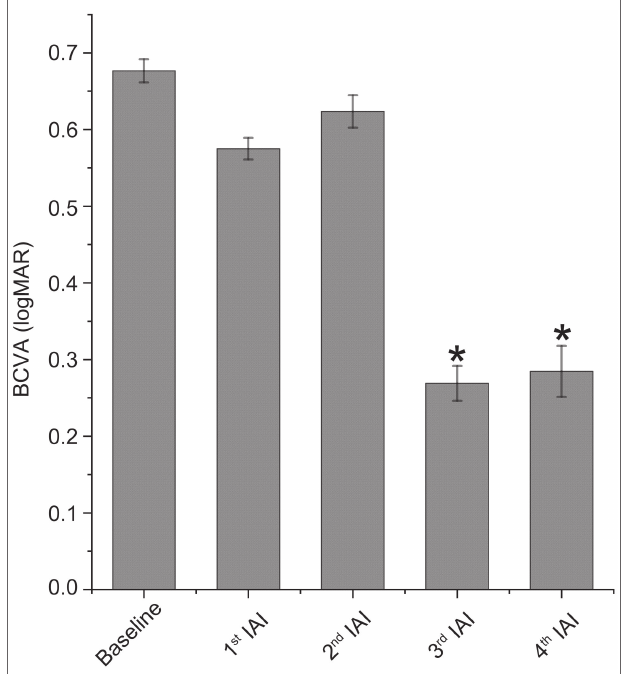
FIGURE 2 | Visual acuity is improved after IAI. BCVA was expressed as logMAR. Data are mean ± SD. n = 21 (baseline), 21 (1st IAI), 17 (2nd IAI), 4 (3rd